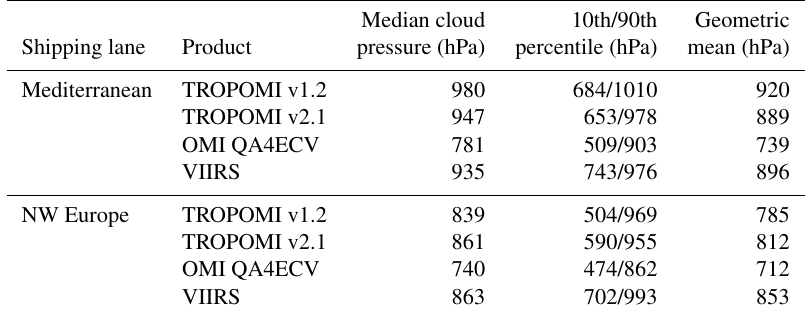
Table D2. Evaluation of TROPOMI v2.1 cloud pressures against reference data for European shipping